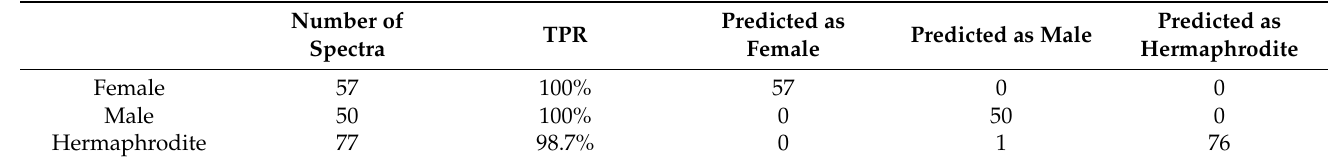
Table 2. Confusion table for spectra collected from hermaphrodite, male and female plants.